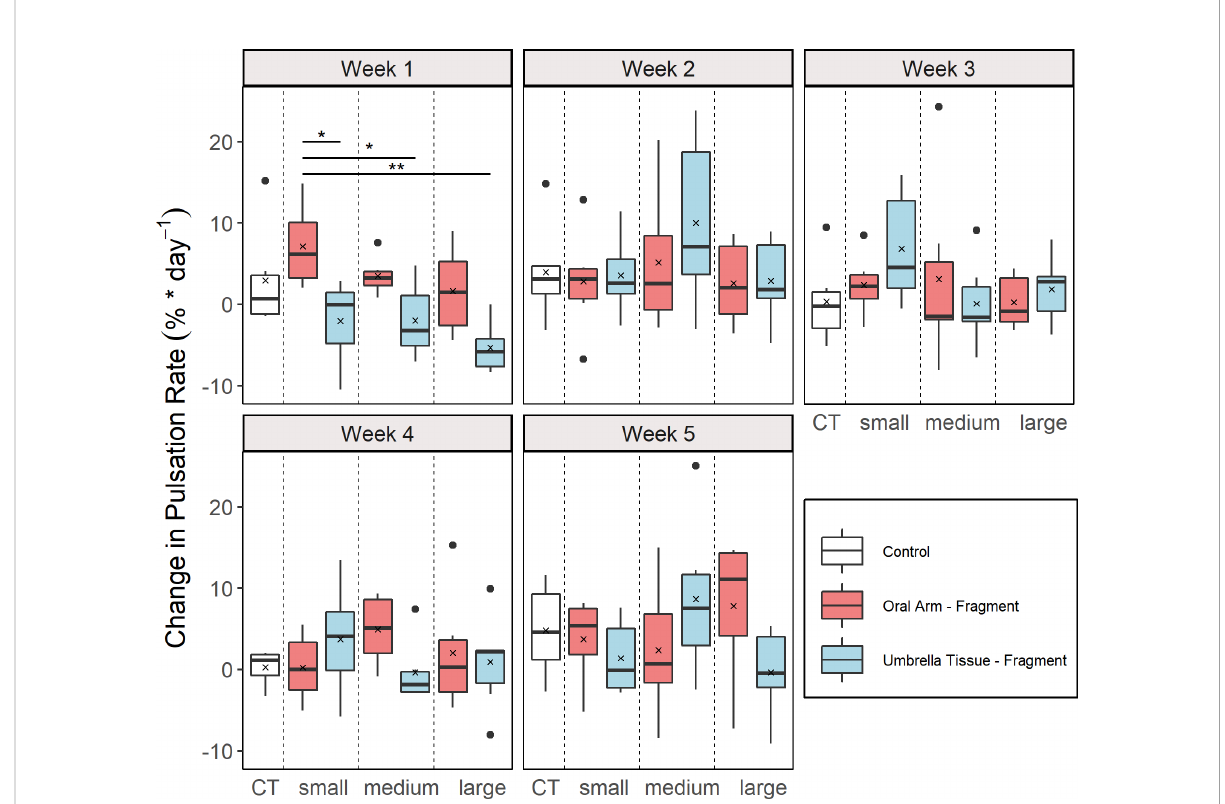
FIGURE 2 Weekly change in pulsation rate (CPR) for the different groups (n = 6 for all groups). Control (CT), oral arm (OA) - and umbrella tissue (UT) - fragments are indicated by white, red and blue color, respectively. The data is presented as boxplots including the median (black line), the mean value (black cross) and outliers (black dots). Signi fi cant differences between groups according to a multiple comparison t-test with Bonferroni adjusted p-values are indicated by asterisks (*p< 0.05, **p<